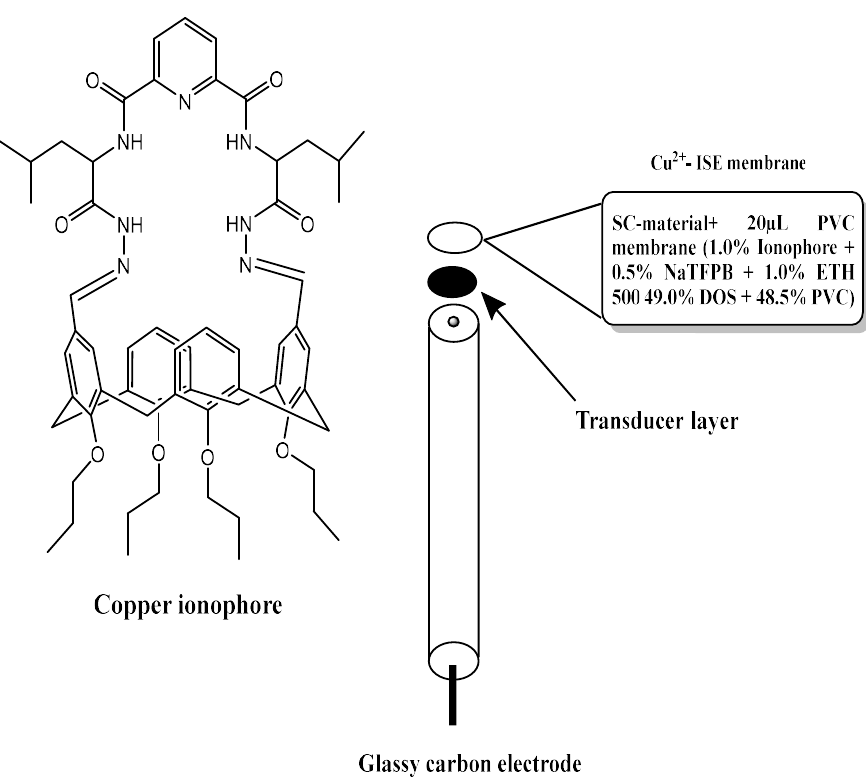
Figure 1. Copper ionophore and electrode design.